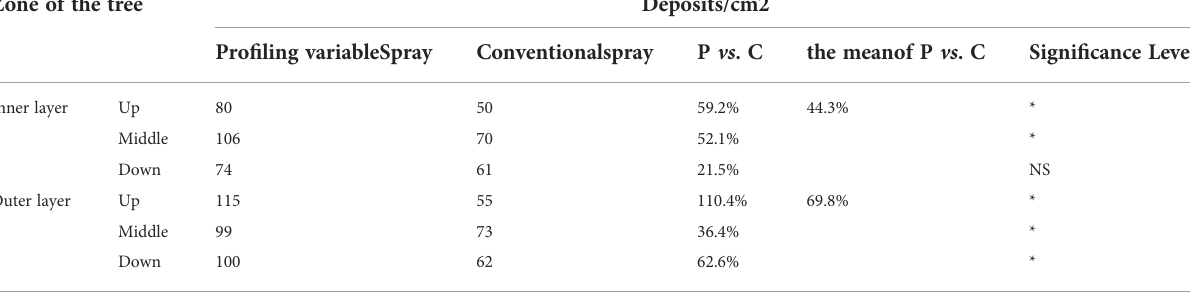
TABLE 1 Droplet deposition density data for different tree zones using the pro fi le variable spraying and conventional spraying. Zone of the tree